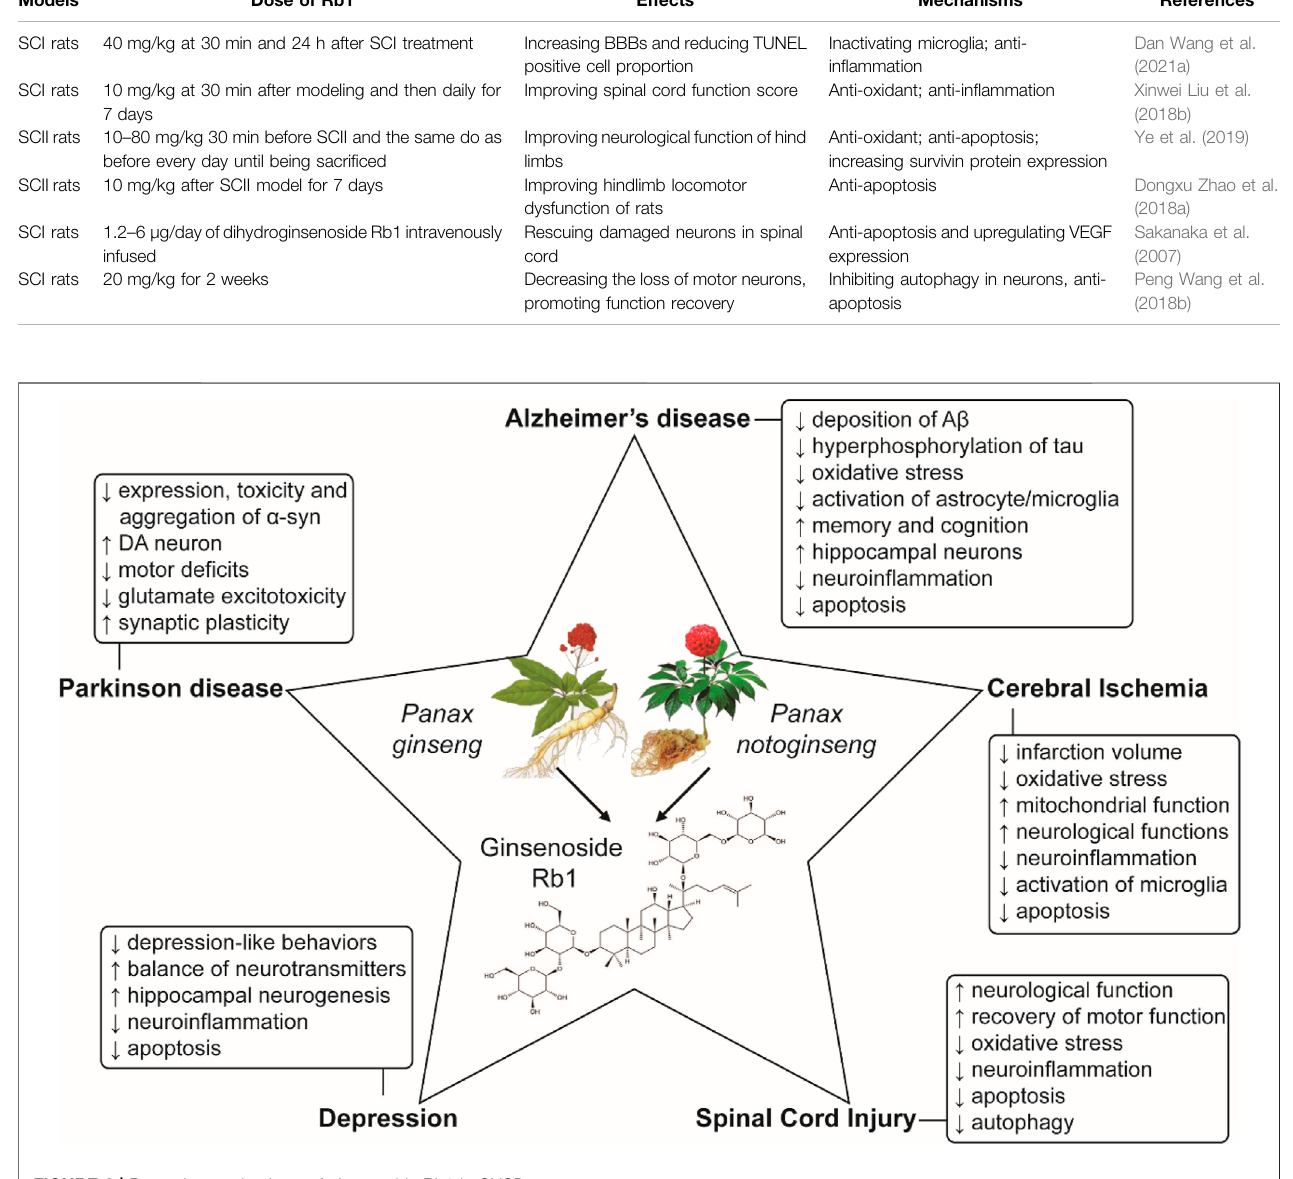
FIGURE 2 | Protective mechanisms of ginsenoside Rb1 in